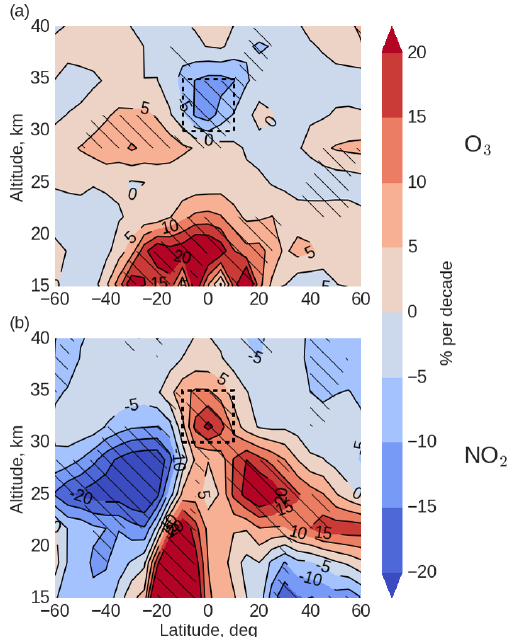
Figure 2. Latitude–altitude distribution of (a) O 3 and (b) NO 2 changes (%decade − 1 ) from MLR applied to SCIAMACHY mea- surements for the January 2004–April 2012 period. Hatched areas show changes significant at the 2 σ level. The dashed rectangle indi- cates the region of the tropical mid-stratosphere investigated in this